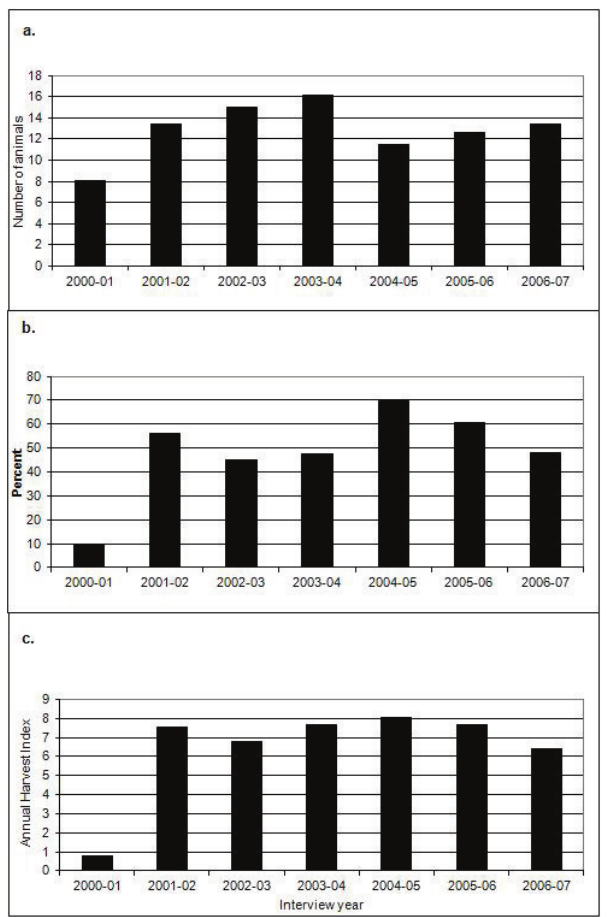
Fig. 3. Summary of harvest information of Porcupine caribou, 2000–2007, based on interviews in user com- munities: average number harvested per successful hunter (a), percent of interviewees that harvested caribou (b), and annual harvest index – the proportion of interviewees that hunted/average number of caribou harvested, HI (c).